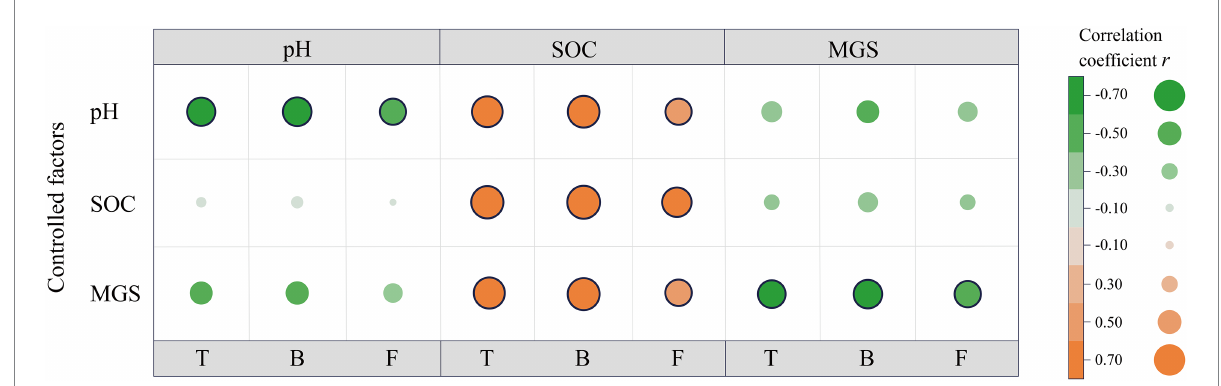
FIGURE 5 Partial correlations between microbial properties and environmental factors in the alpine desert. Pearson correlation coefficients between the environmental factors (pH, soil organic carbon [SOC] and mean grain size [MGS]) and microbial properties (total phospholipid fatty acids [PLFAs; T], bacterial PLFAs [B], fungal PLFAs [F]) are displayed at the intersection of the same environmental factors in the matrix. The colors of the points indicate the strength and sign of the correlation, and the black frame line indicates the significant correlation at the significance level of 0.05. The color differences observed between the correlations (matrix) and controlled factors indicate the extent to which the correlation between microbial properties and the examined factors is influenced by the control variables (no change in point color between the partial correlations and correlations = no dependency; a decrease/increase in point color intensity = loss/gain of